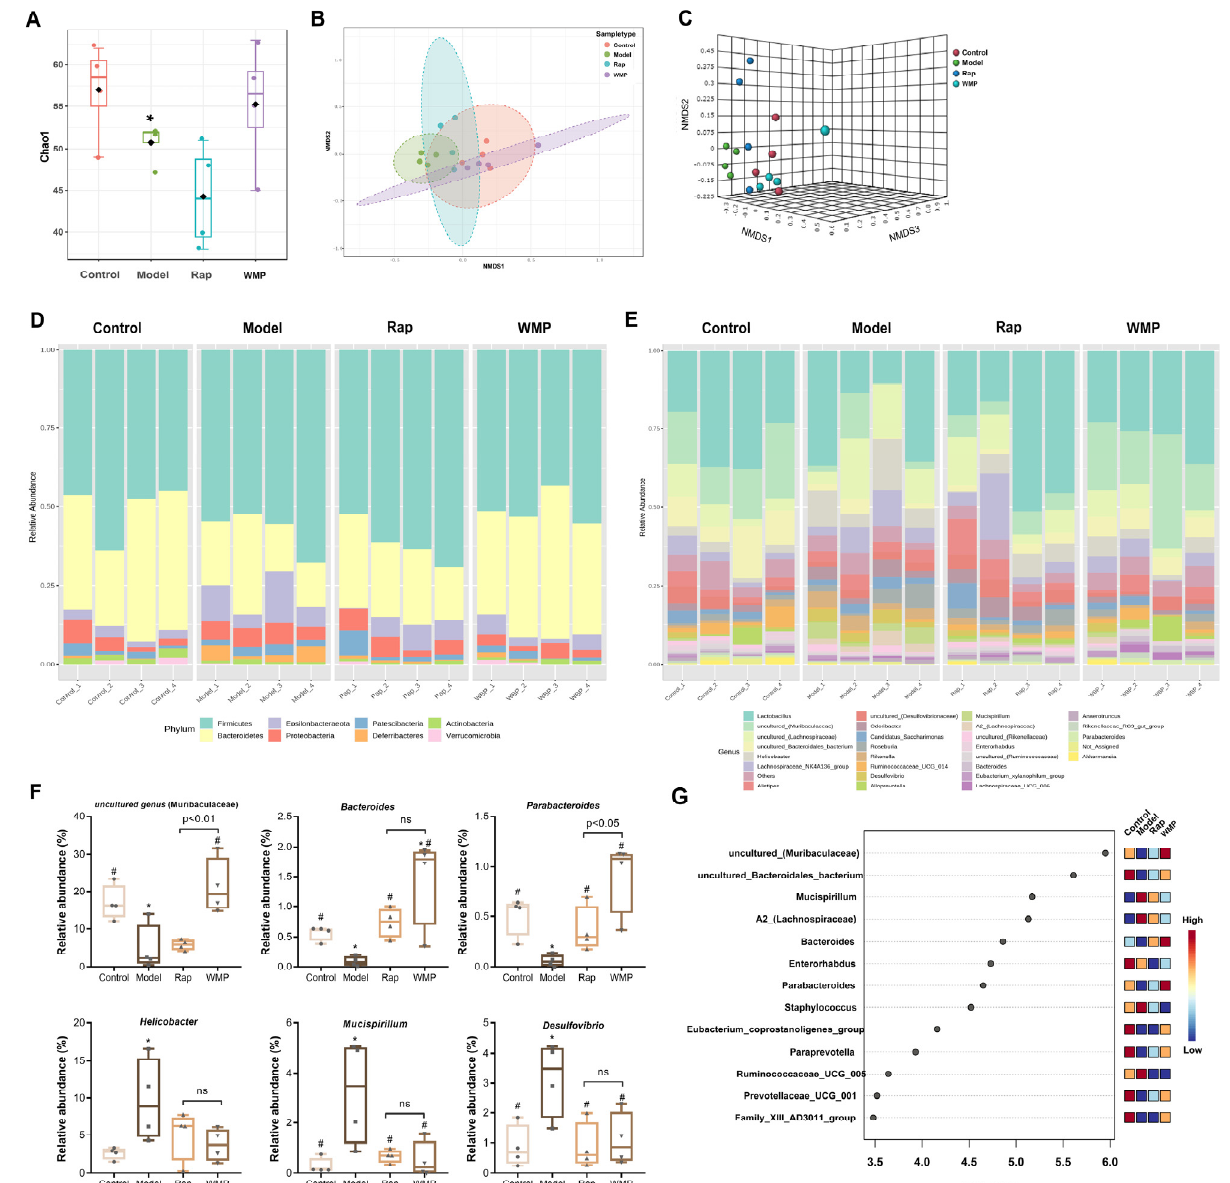
Figure 5. Effects of WMP on the diversity and composition of gut microbiota in mice. ( A ) Boxplots of the Chao 1 index for the gut microbiota. ( B , C ) The 2D and 3D plots of the scores of the principal component analyses of the gut microbiota. ( D – F ) The relative abundance of the gut microbiota at the phylum and genus levels. ( G ) The significantly changed genus screened by the random forest method. * p < 0.05 vs control group and # p < 0.05 vs model group; ns: not